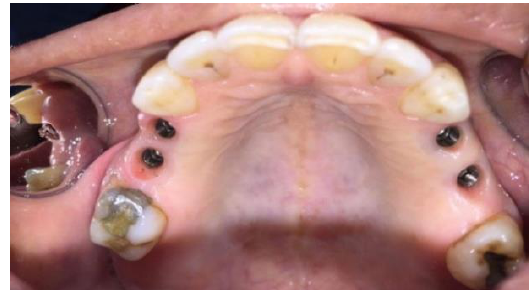
Figure (4): Detaching of healing abutments 12 weeks postoperatively.